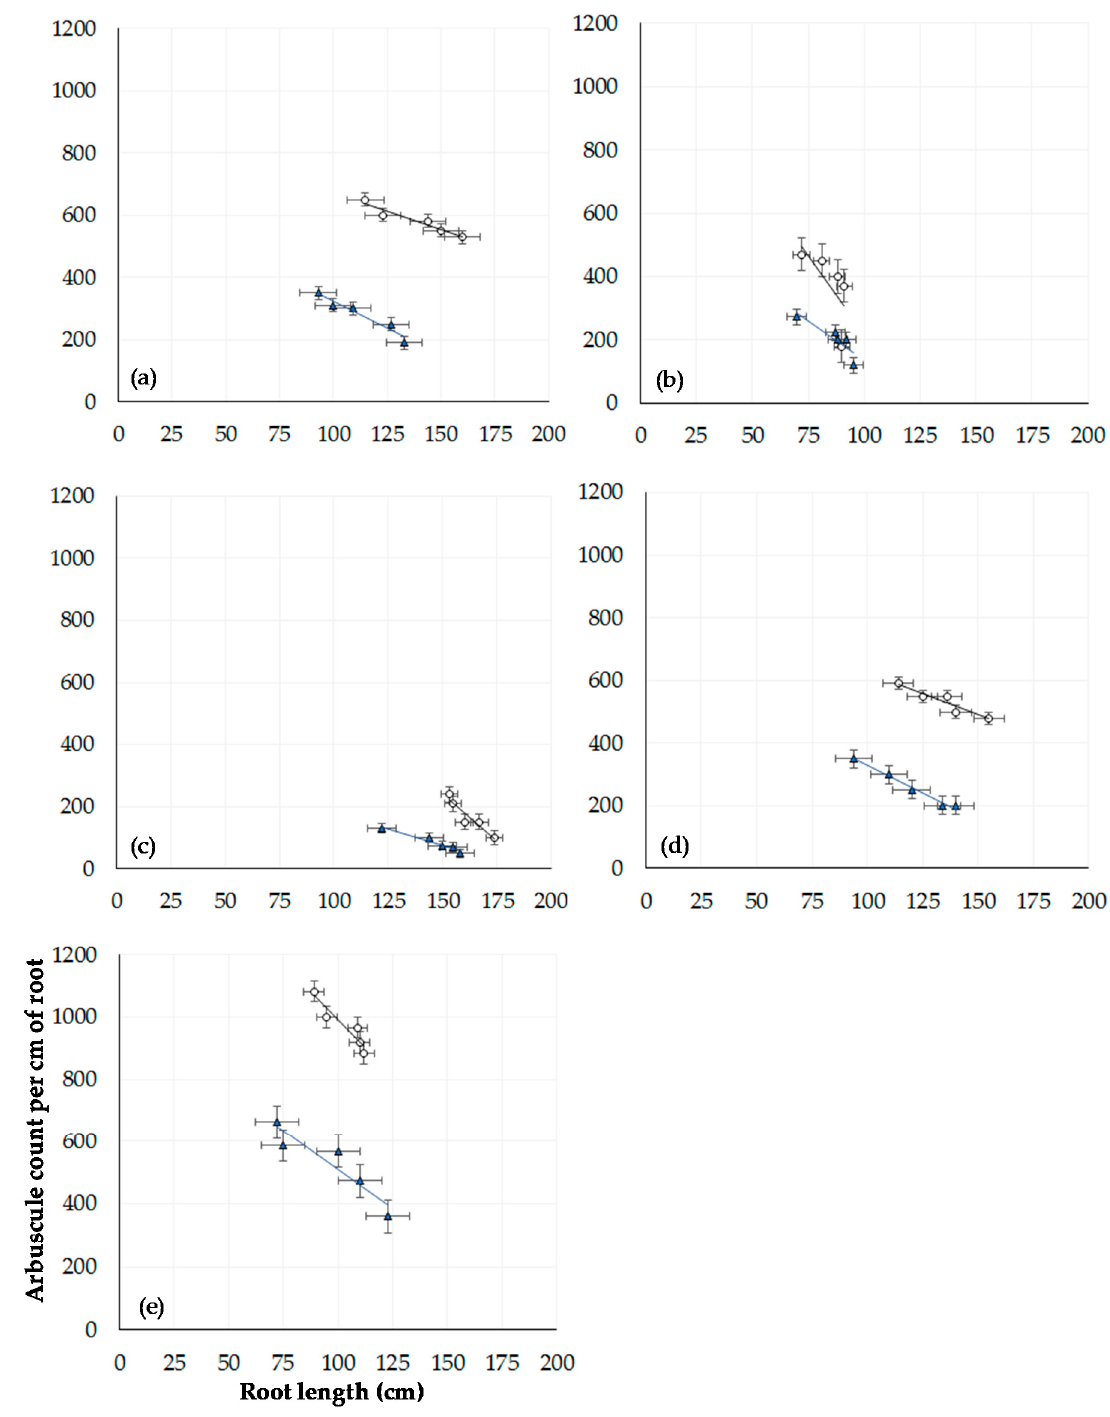
Figure 4. Relationship between root length and arbuscule count ( n = 300) at week 15 in 60 winter wheat plants grown in field extracted soil managed under either conventional (blue triangle) or zero tillage (white circle): ( a ) control with zero inoculant, ( b ) AM fungi, ( c ) B. subtilis , ( d ) B. pumilis , and ( e ) B. amyloliquefaciens . Error bars = one SEM.